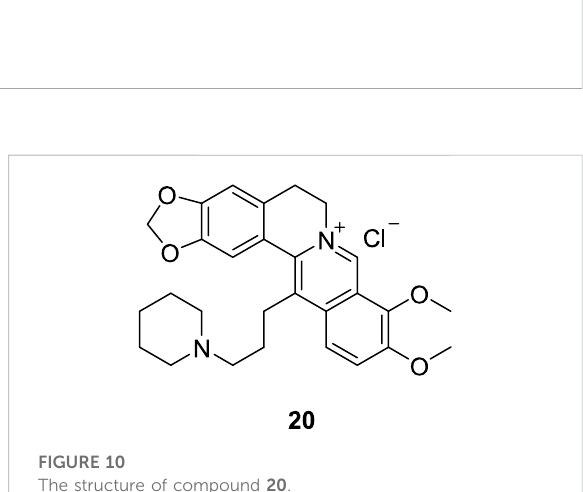
FIGURE 9 The structures of compounds 18 and 19 .